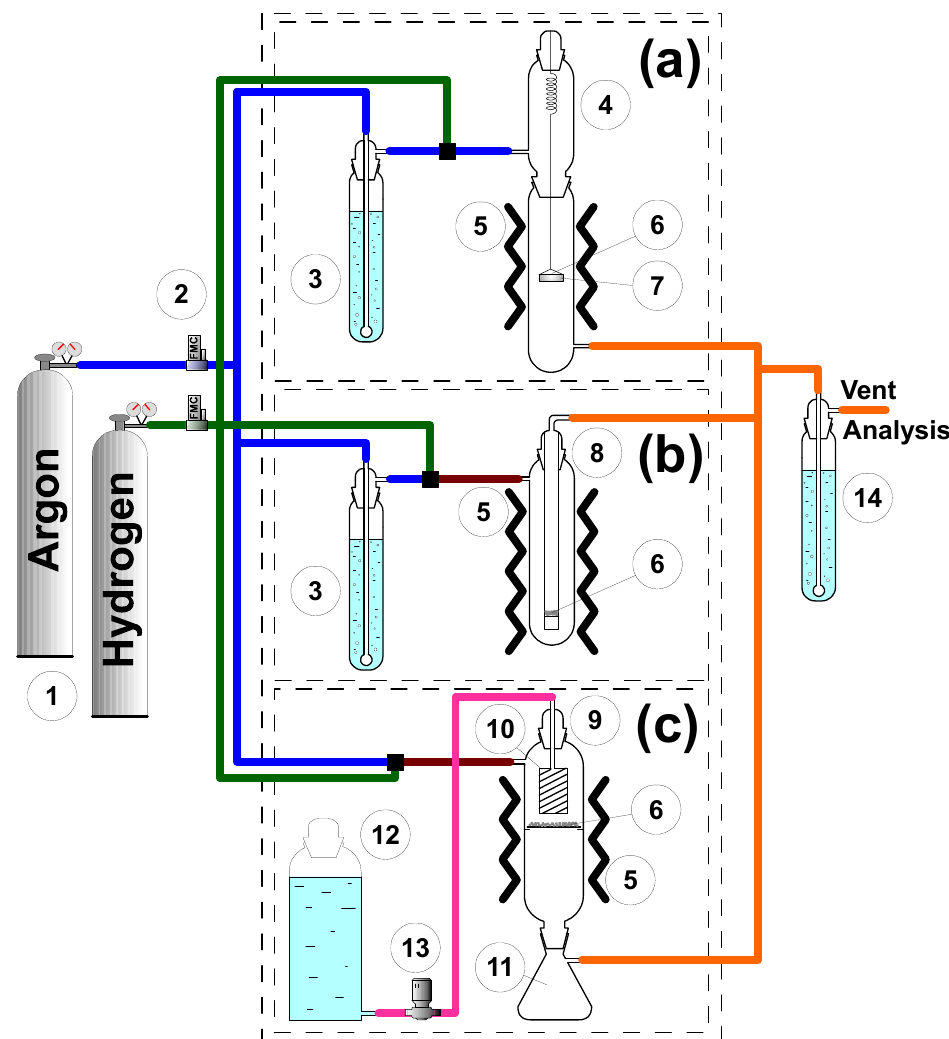
Figure 1. Principal schemes of the experimental installations equipped with reactor #1 ( a ), reactor #2 ( b ), and reactor #3 ( c ) and used for scaling up the process of catalytic decomposition of chlorinated hydrocarbons: 1—gas cylinders; 2—flow mass controllers; 3—saturator with DCE; 4—quartz reactor with McBain balance; 5—heating zone; 6—catalyst’s sample; 7—foamed quartz basket; 8—lab flow-through quartz reactor; 9—scaled-up quartz reactor; 10—evaporator; 11—carbon collector; 12—vessel with DCE; 13—pump; 14—alkali trap.